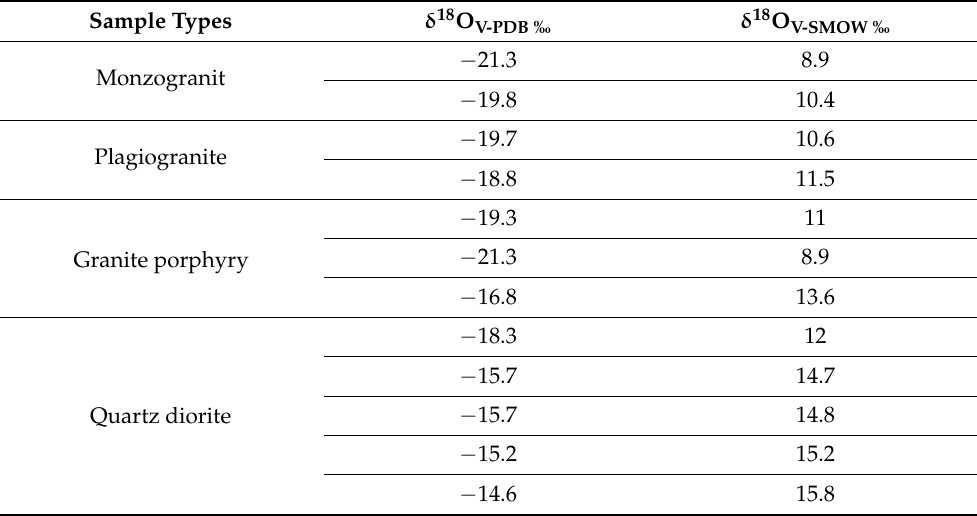
Table 3. Oxygen isotopic compositions of Asiha complex.